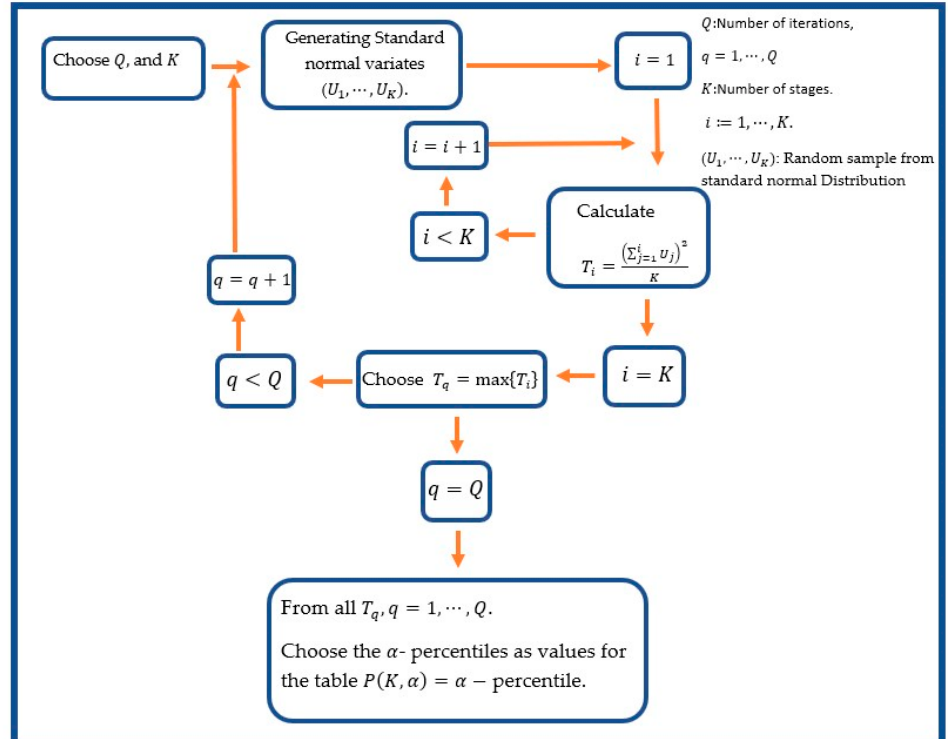
Figure 1. Evaluation of the O’Brien and Fleming Stopping Bound. Percentile estimates based on 10,000 samples are listed in Table 1 [16].